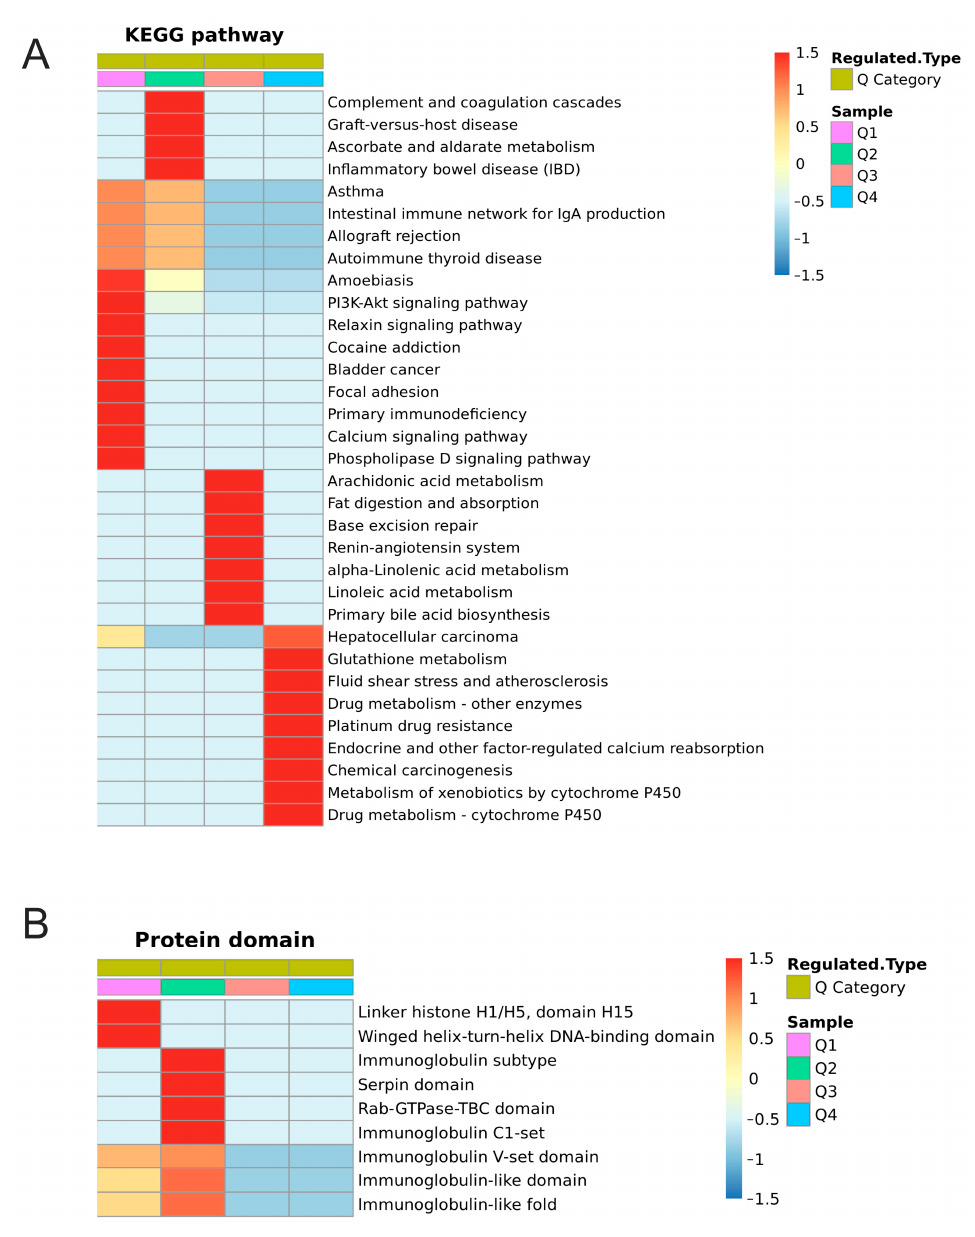
Figure 8. Cluster Analysis of DEPs based on KEGG pathway and protein structural domain enrichment analysis. ( A ) Heat map for cluster analysis of DEPs based on KEGG pathway analysis. ( B ) Heat map for cluster analysis of DEPs based on protein structural domain enrichment.